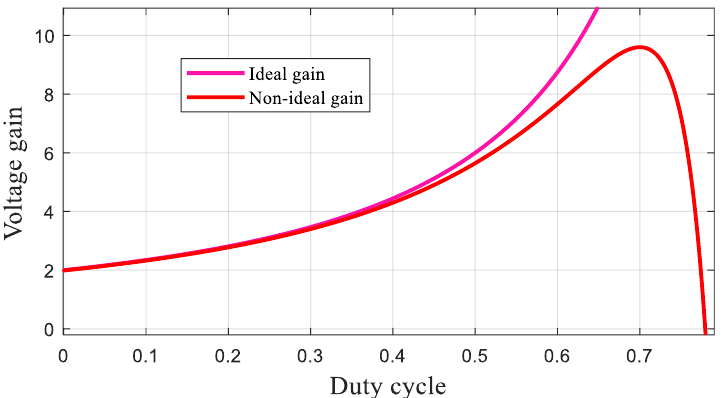
Figure 4. The comparison of the ideal and non-ideal voltage gain of the proposed converter.